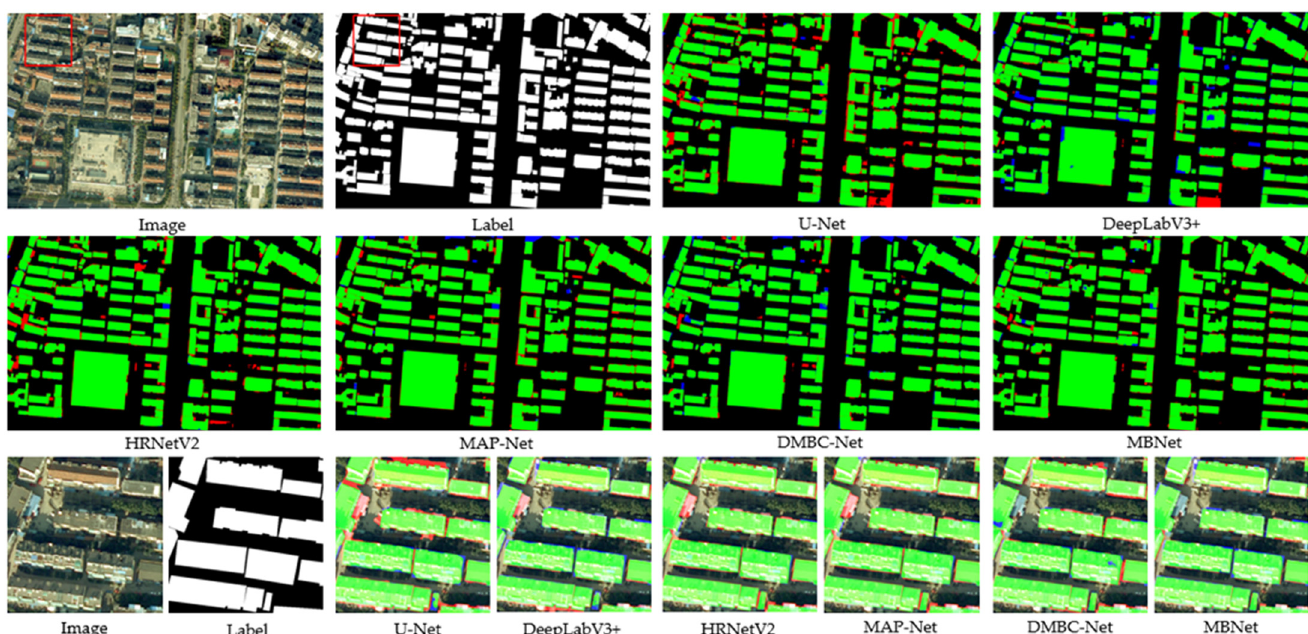
Figure 16. Segmentation results of the different SOTA methods on the suburban dense area scene 2 test dataset. The bottom row is a close-up view of the red box.